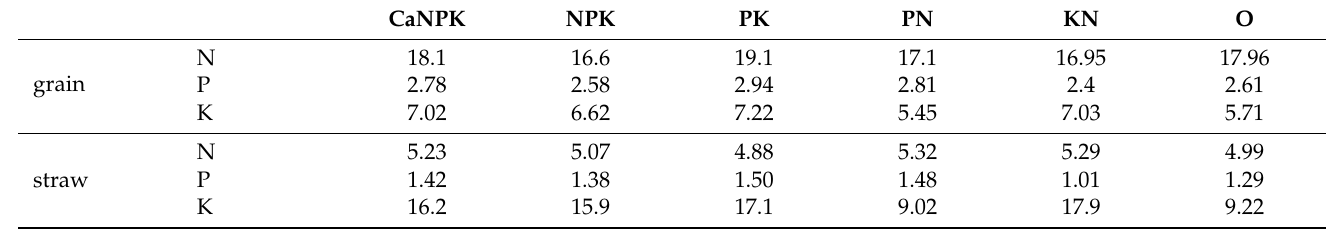
Table 3. Content of N, P, K in grain and straw in g kg − 1 in experiment 1 (with crop rotation) in 2017.